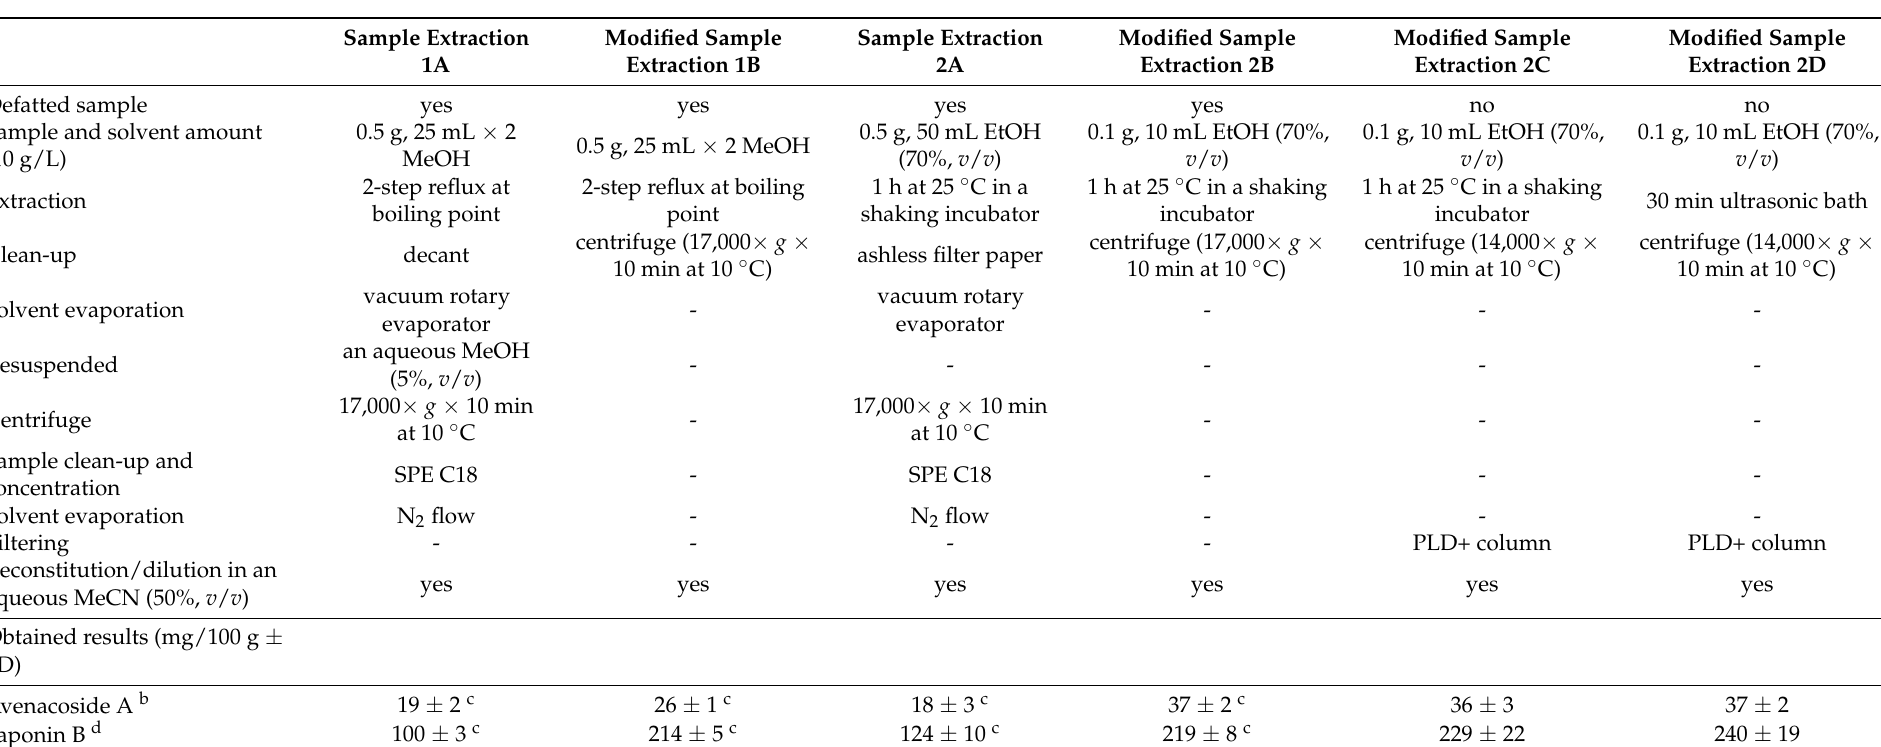
Table 1. The extraction steps of reference methods 1A and 2A [9,19], their modified versions (1B, 2B, 2C, and 2D), and saponin yields obtained using these methods a